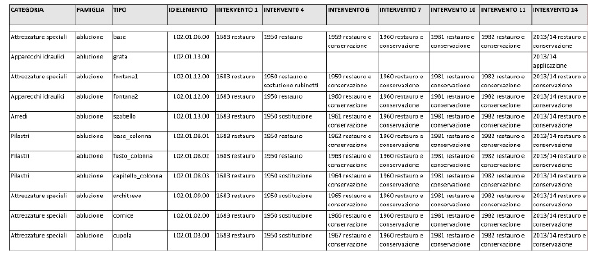
Figure 9. A section of the relational database